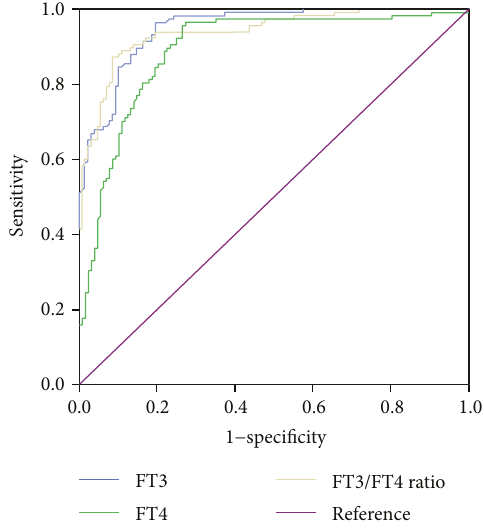
Figure 3: Receiver operating characteristic (ROC) curve for the discrimination of patients with Graves ’ disease from healthy controls and patients with destructive